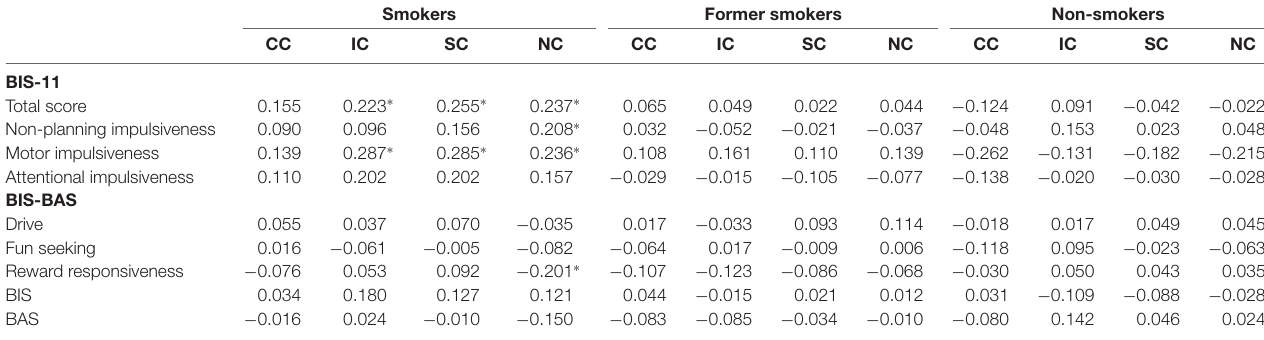
TABLE 3 | Correlations’ value ( r, p ) between BIS-11, BIS-BAS and response latencies in Emotional Smoke Stroop Task.